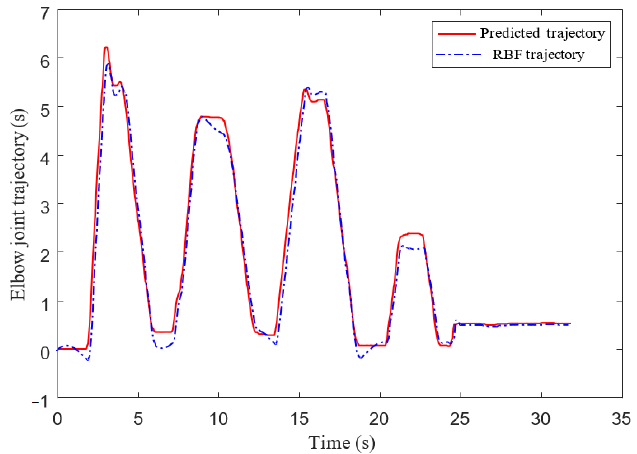
Figure 10. Comparison of predicted trajectory and processed trajectory.